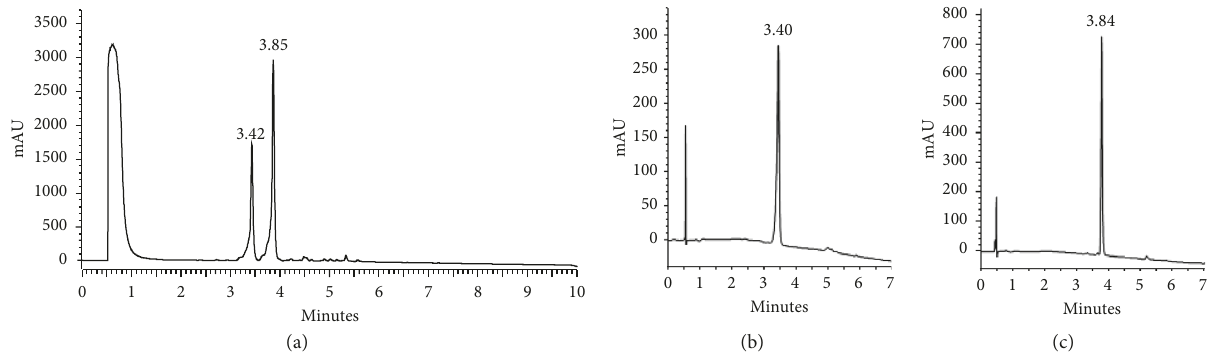
Figure 4: RP-HPLC profiles. (a) Conformational mixture. (b) Crown conformer. (c) Chair